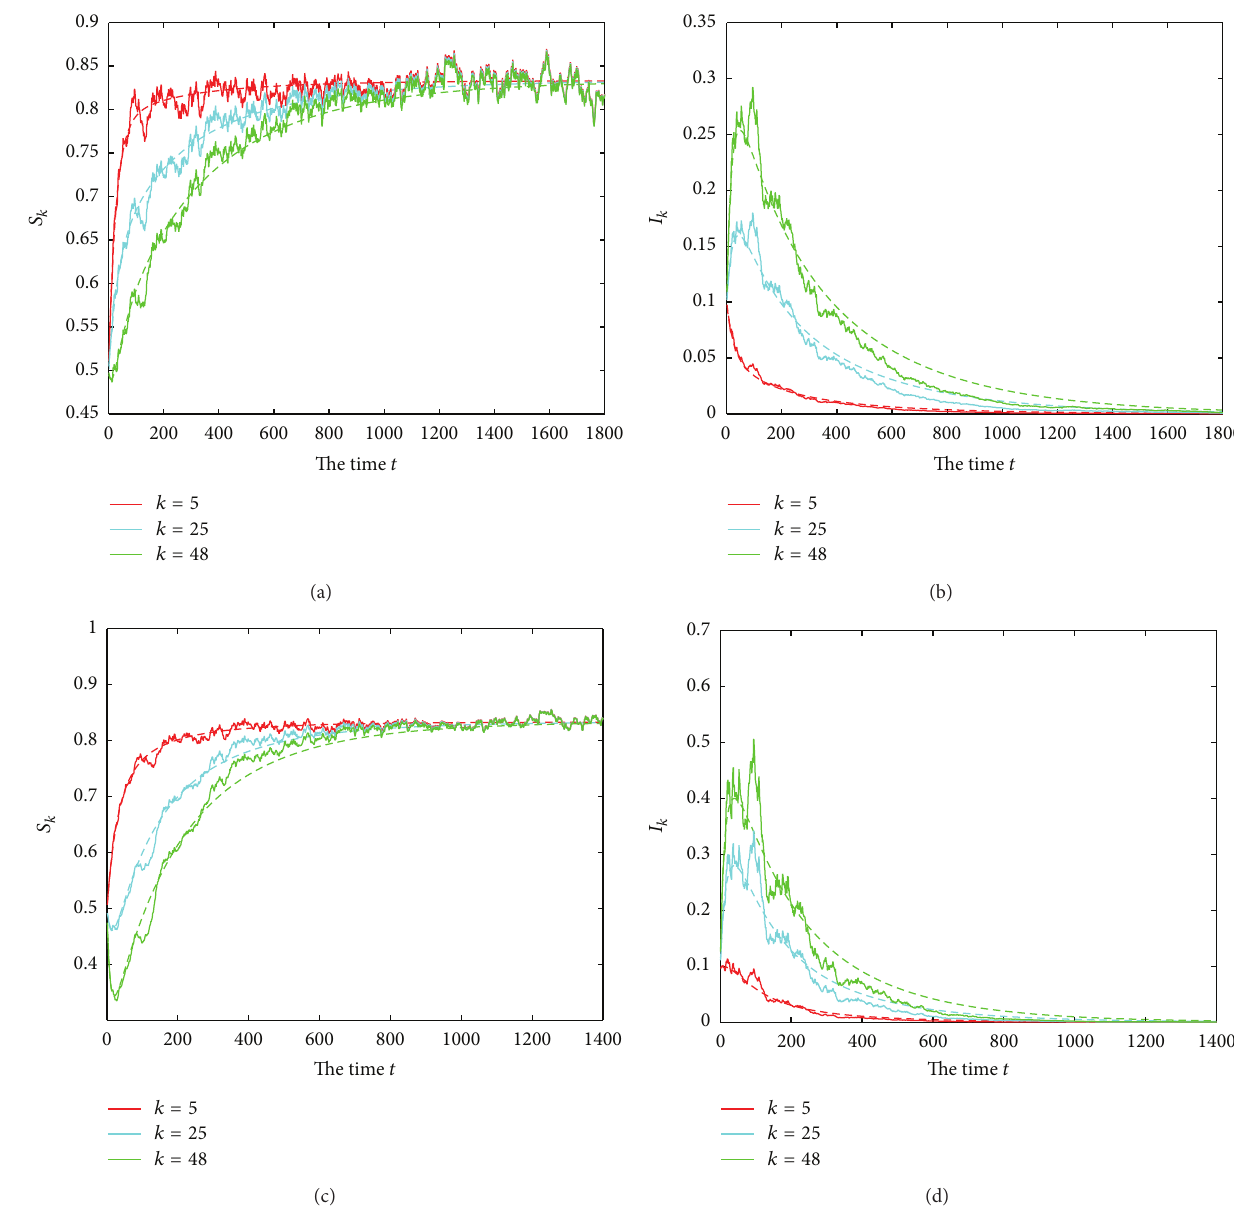
Figure 4: (a), (b) 𝜆 = 0.05 , 𝜎 𝑘1 = 0.015 , 𝜎 𝑘2 = 0.05 , 𝑃(𝑘) = 𝑚 𝑘 exp (−𝑚)/𝑘! , 𝑚 = 6 , 𝑅 0 = 0.94.9 ≤ 1 . (c), (d) 𝜆 = 0.025 , 𝜎 𝑘1 = 0.01 , 𝜎 𝑘2 = 0.1 , = 0.9071 ≤ 1 𝑃(𝑘) = 2𝑚 2 𝑘 −3 , 𝑚 = 3 , 𝑅 0